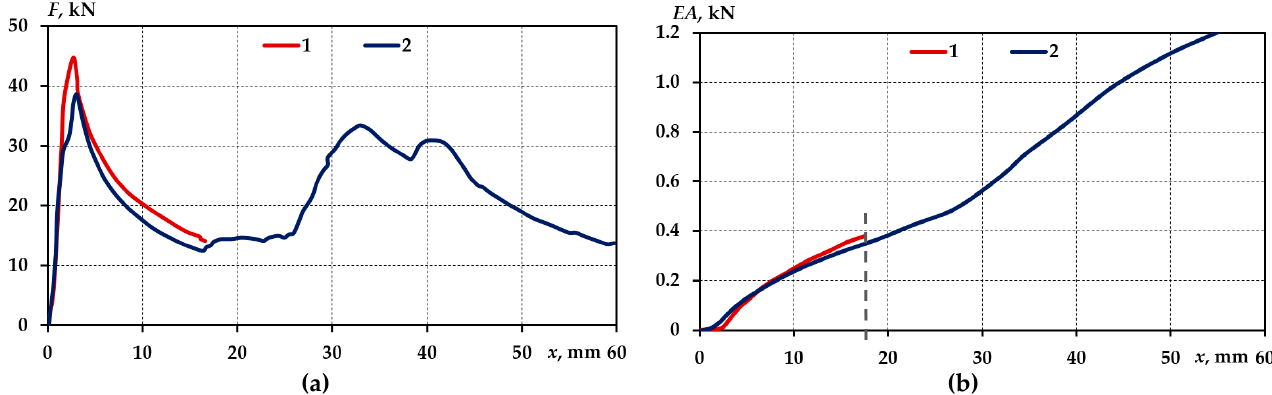
Figure 7. Deformation forces obtained during quasi-static experiments: axial displacement diagrams ( a ) and absorbed energy amount ‒ axial displacement diagrams ( b ); (1—original part; 2—part with the restored geometry).